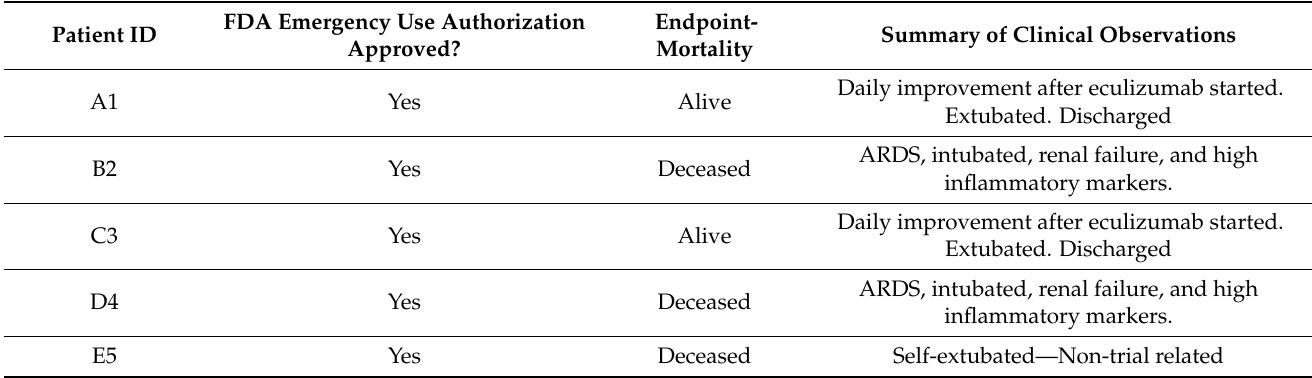
Table 6. Patients Who Received